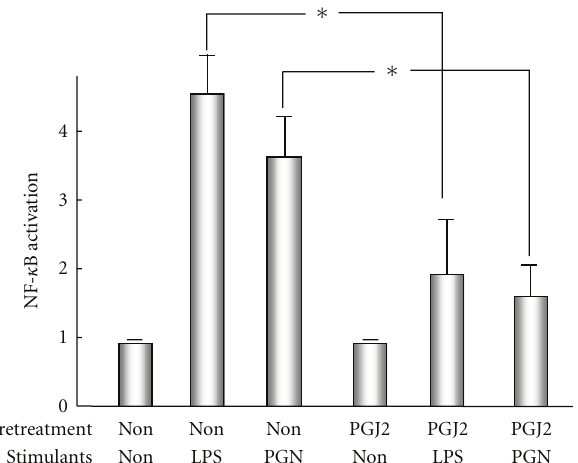
Figure 6: E ff ect of the peroxisome proliferator-activated receptor γ (PPAR γ ) ligand, 15d-PGJ2, on lipopolysaccharide (LPS, TLR4 ligand)- and peptidoglycan (PGN, TLR2 ligand)-induced NF- κ B activation in cultured human biliary epithelial cells (BECs). BECs are pretreated in the presence or absence of 15d-PGJ2 (20 μ M) before stimulation with LPS or peptidoglycan. Pretreatment with 15d-PGJ2 significantly prevents PAMP-induced NF- κ B activation ( ∗ < .